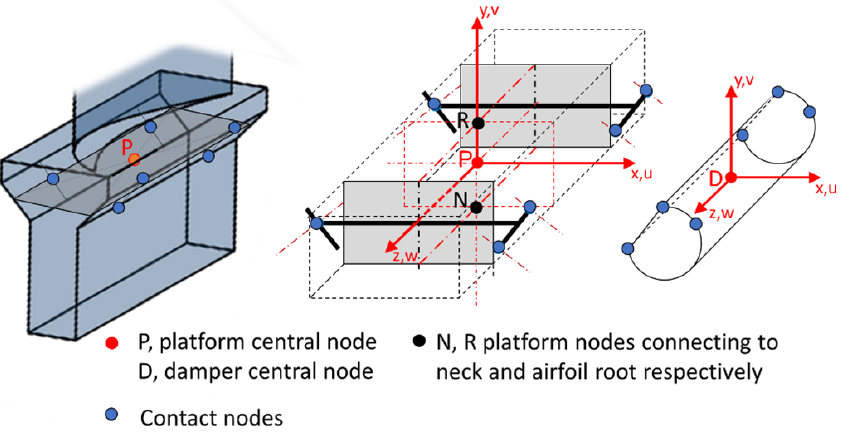
Figure 1. ( Left ) 3D view of the platform PCR representation through six DoFs (three displacements and three rotations) at point P. ( Right ) 3D view of the damper rigid body representation through six DoFs (three displacements and three rotations) at point